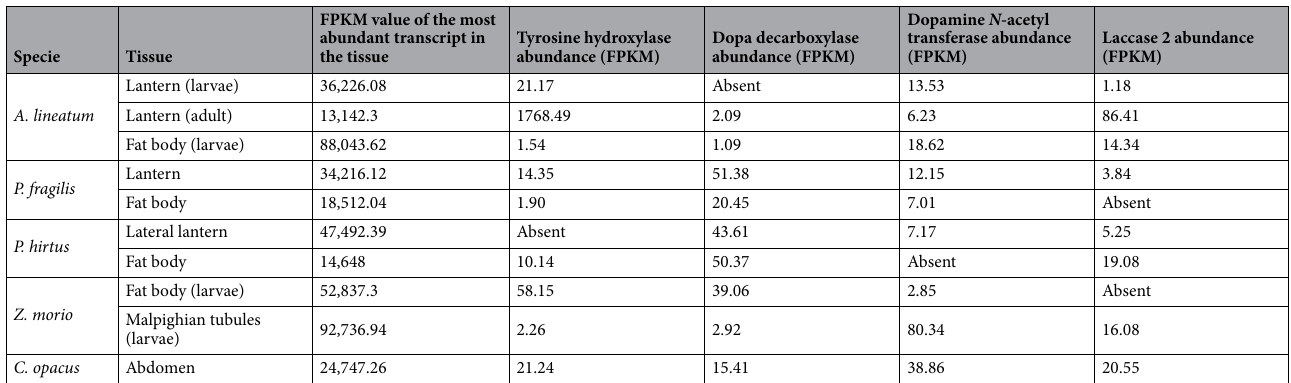
Table 1. Transcripts similar to enzymes involved with pigmentation/sclerotization pathway that were found in firefly lanterns and non-bioluminescent tissues of Coleoptera species. Abundance values (FPKM) of these transcripts also are